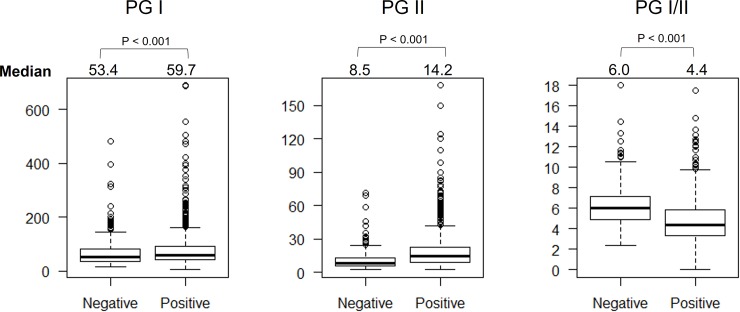
The pepsinogen level and the gastric abnormality.The gastric abnormality was assessed as any gastric mucosal changes either neutrophil and monocyte infiltration, gland atrophy or intestinal metaplasia. We observed the PGI and PGII was significantly higher and PGI/II ratio was significantly lower in individual with gastric abnormality than normal one.